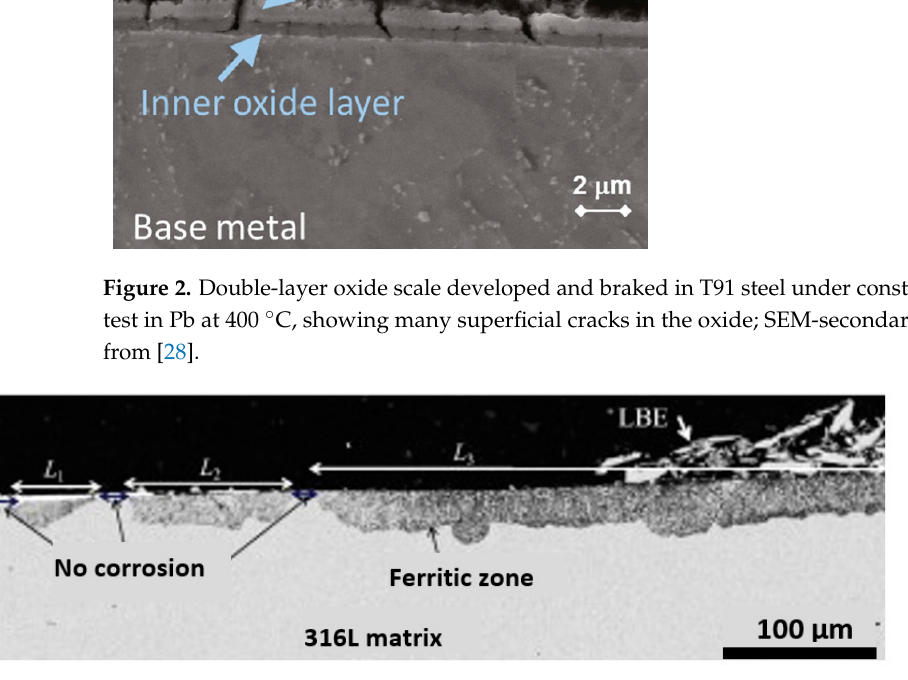
Figure 2. Double-layer oxide scale developed and braked in T91 steel under constant extension rate test in Pb at 400 °C, showing many superficial cracks in the oxide; SEM-secondary electrons image from [28].